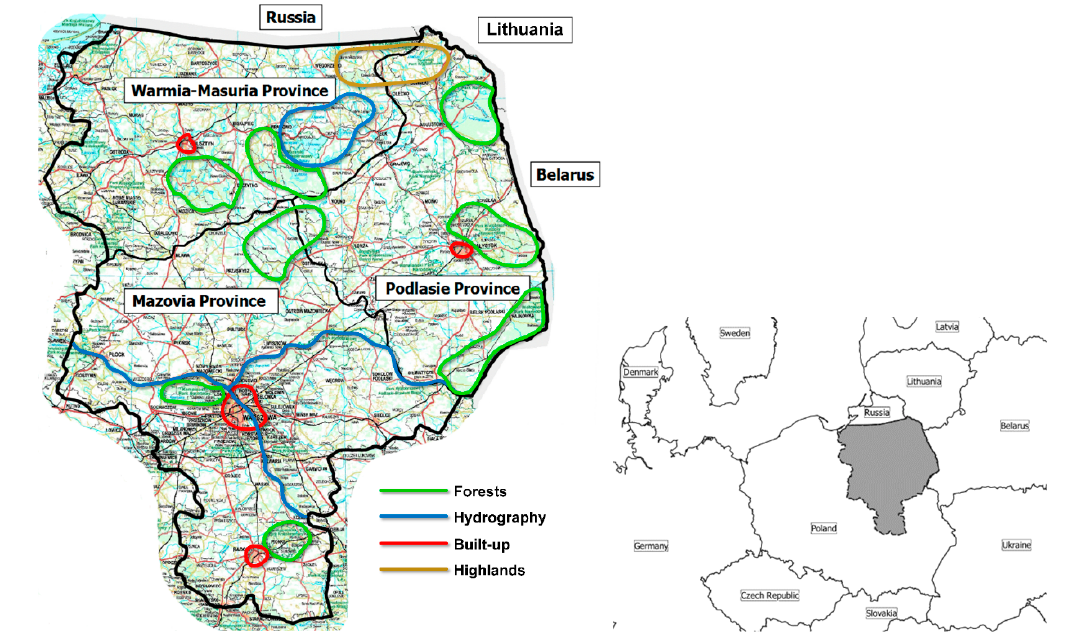
Figure 1 . The study area. Figure 1. The study area.